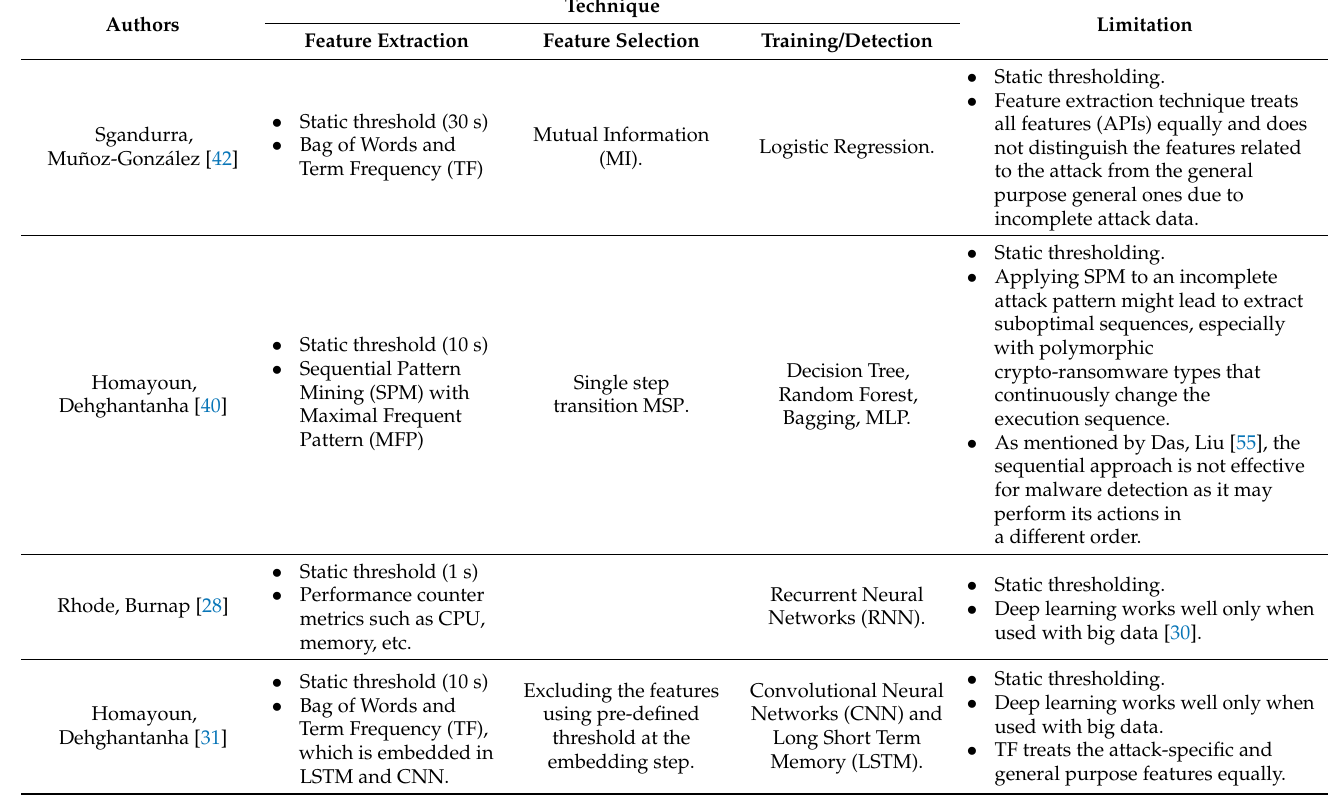
Table 1. Limitations of existing crypto ransomware early detection